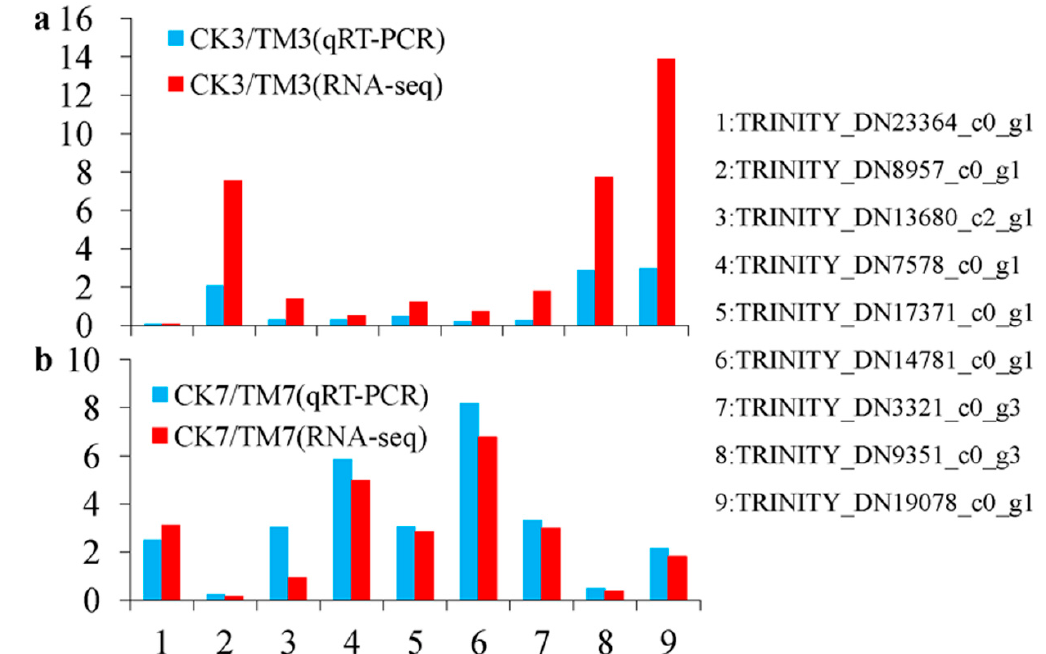
Figure 6. DEGs confirmed by qRT–PCR using the same samples as in the RNA-seq. ( a ) Results from CK3 vs. TM3 and ( b ) CK7 vs. TM7. The blue column represents the qRT–PCR results and the red column represents the RNA-seq results. The y -axis represents the fold change of the relative expression levels of DEGs.